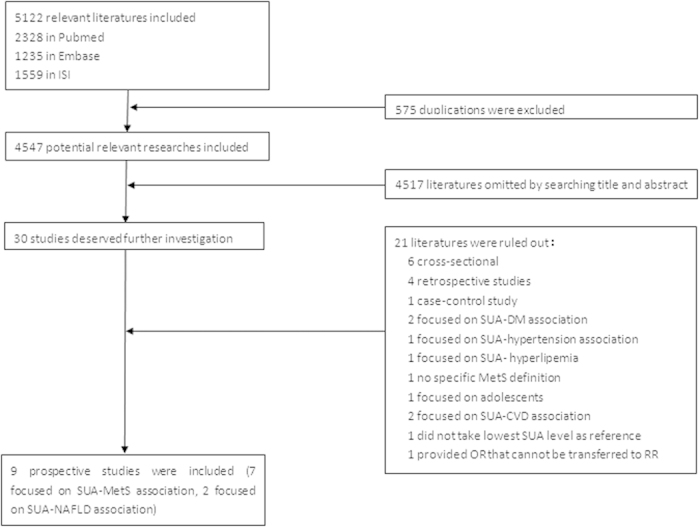
Flow diagram of eligible literature selection.